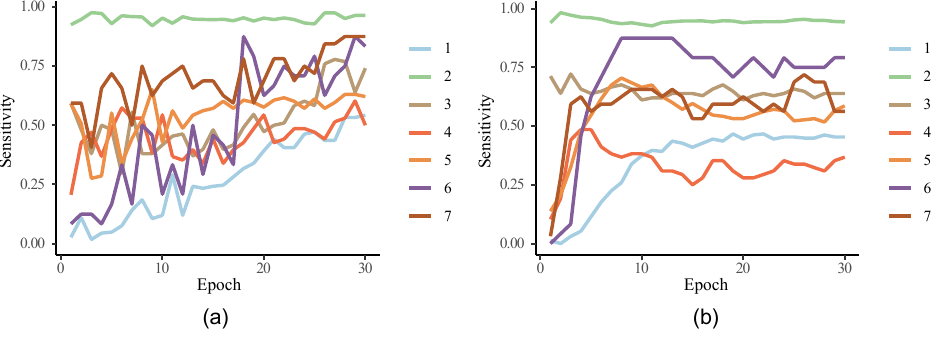
Figure 6. ( a ) A graph of the sensitivity changes of each category under our method. ( b ) A graph of the sensitivity changes of each category under the basic network.